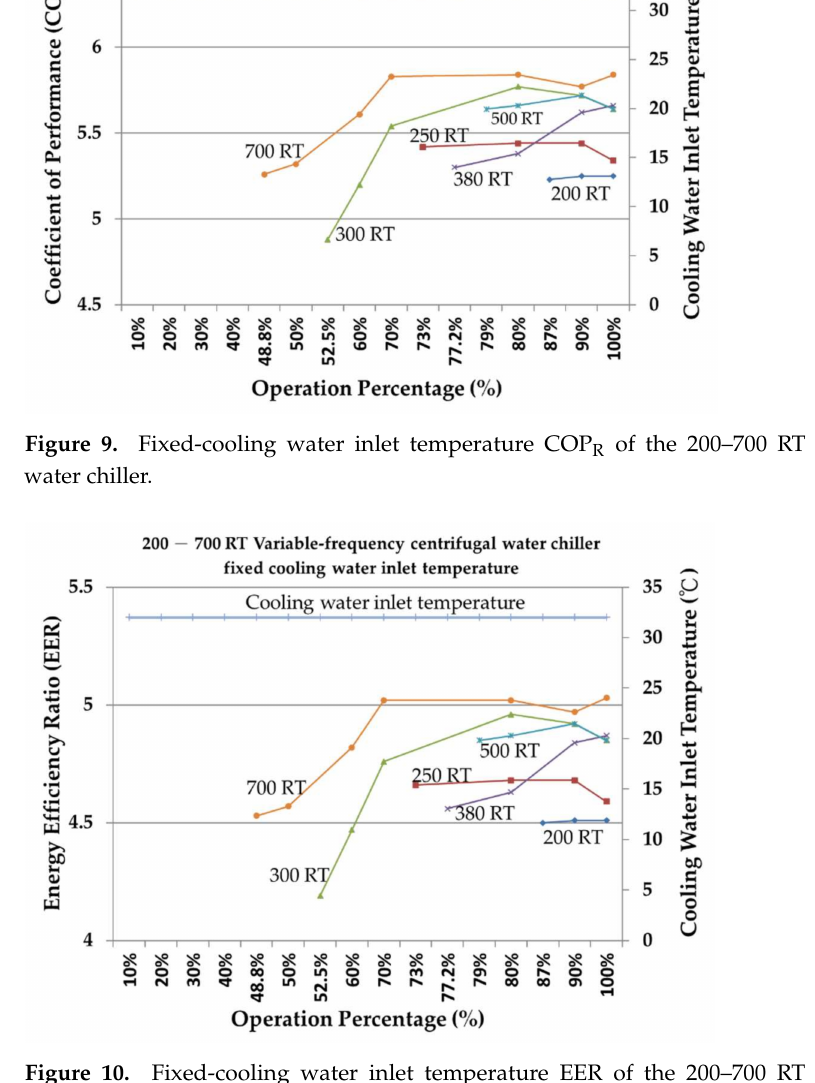
Figure 10. Fixed-cooling water inlet temperature EER of the 200–700 RT variable-frequency water